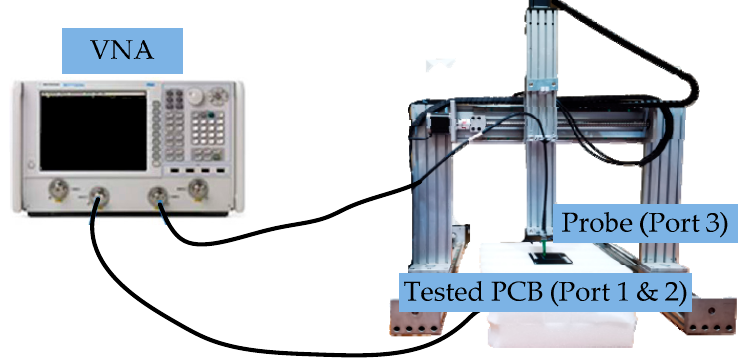
Figure 3. Setup for the transfer function measurement.